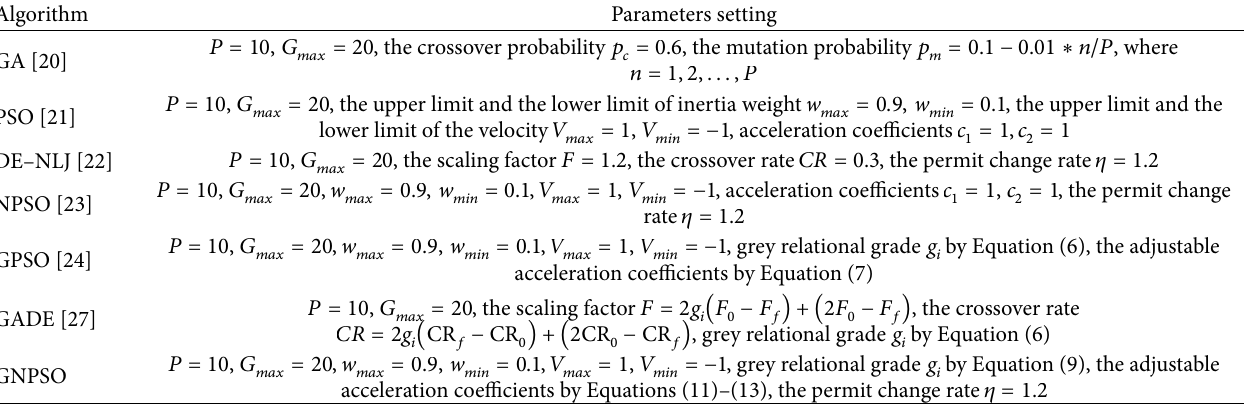
Table 1: Parameters setting of GA, PSO, NPSO, GPSO, DE–NLJ, GADE and GNPSO for optimal IMC-PID control of the linear wing vibra- tion system. Algorithm Parameters setting